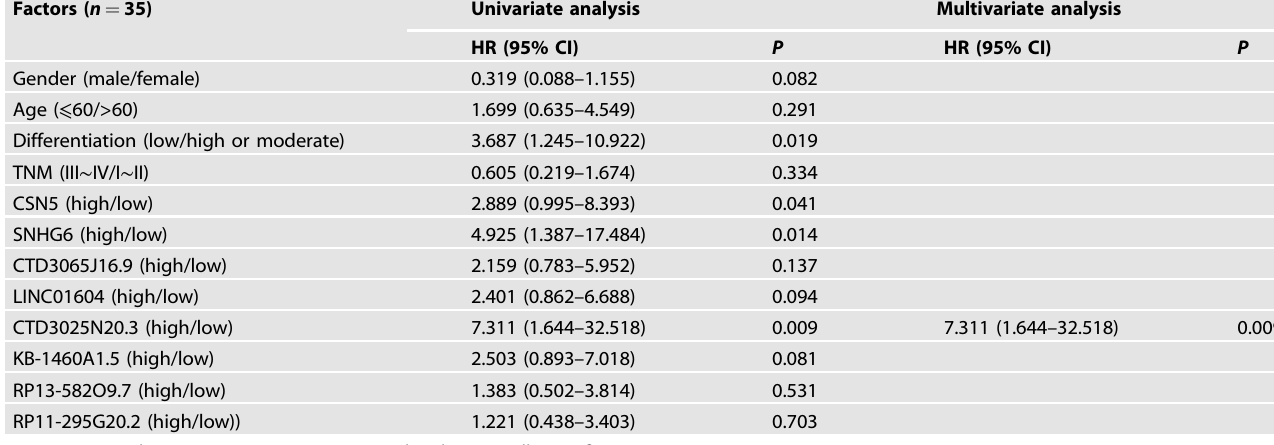
Table 1. Prognostic factors in Cox proportional hazards